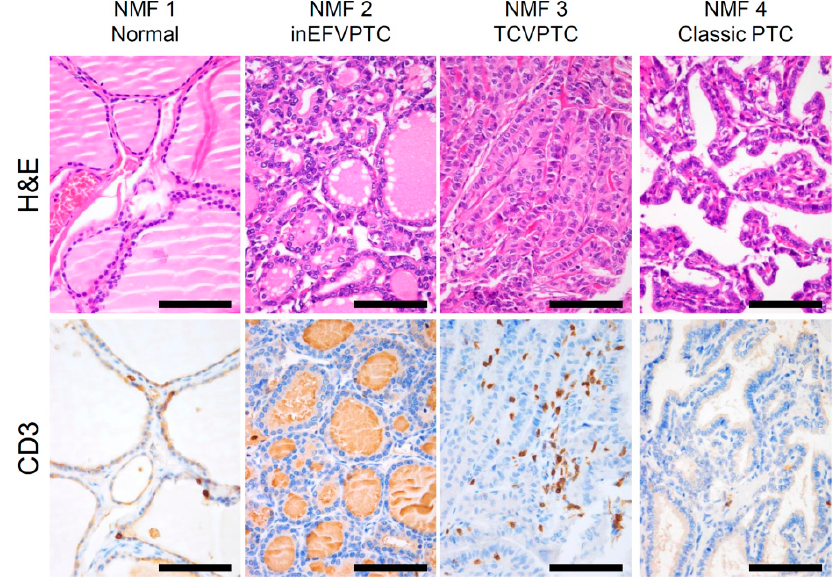
Figure 3. H&E staining of papillary thyroid carcinoma and adjacent normal thyroid tissue across the 4 NMF clusters with representative images showing staining for pan T-cell marker CD3. inEFVPTC = invasive encapsulated follicular variant of papillary thyroid carcinoma; TCVPTC = tall cell variant of PTC. Scale bar = 100 μ m